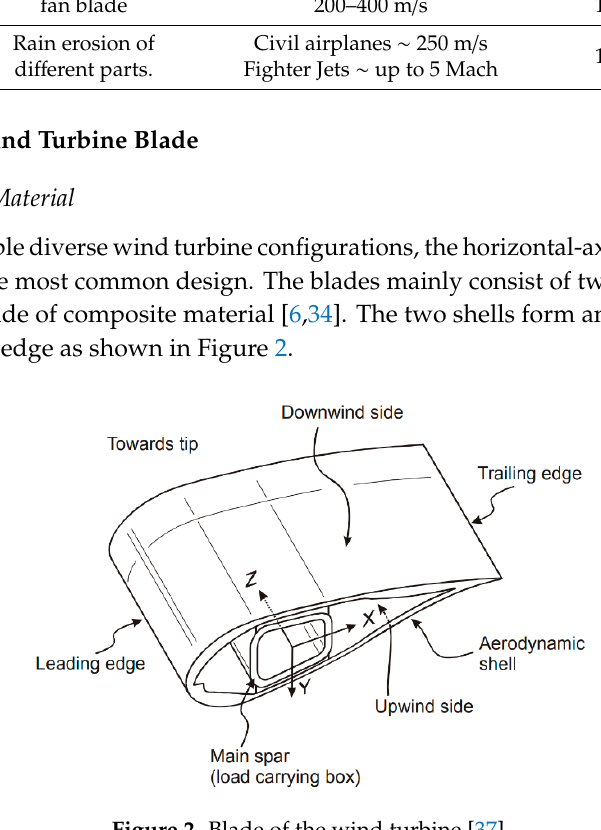
Table 1. Summary of the erosion conditions in some applications.